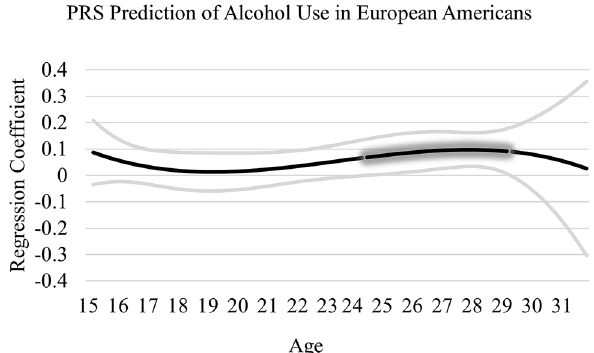
Figure 2. PRS prediction of alcohol use in European Americans. Graph represents age-varying strength of the association between the PRS and alcohol use in European Americans from 15 to 31 years of age. Regression coefficient estimates are represented by the black line and the 95% confidence interval by the gray lines. The “glowing” portion represents a significant association where the 95% confidence interval departs from